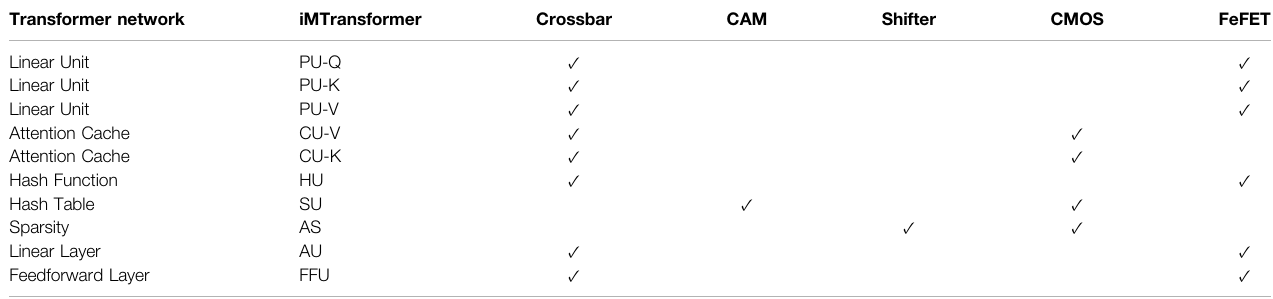
TABLE 1 | Summary of hardware mapping of Transformer Network to iMTransformer. Transformer network